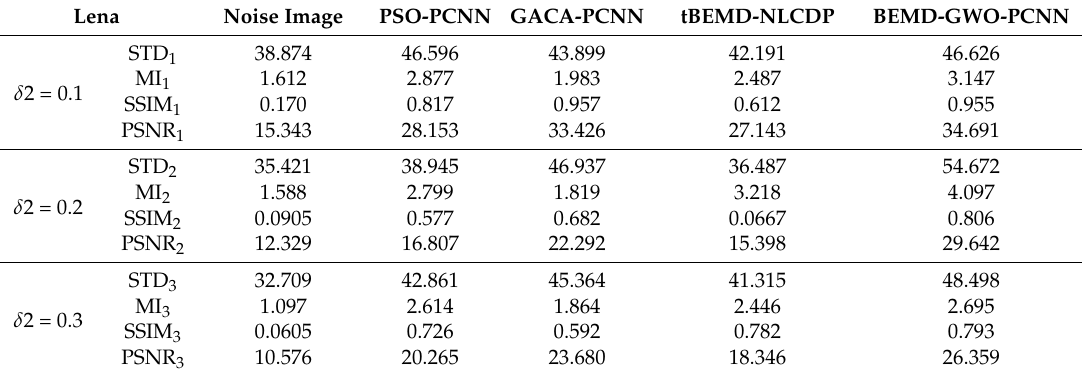
Table 4. Comparison of the adaptive PCNN combined with BEMD method with other current denoising methods corresponding to different noise intensity values δ in Lena.